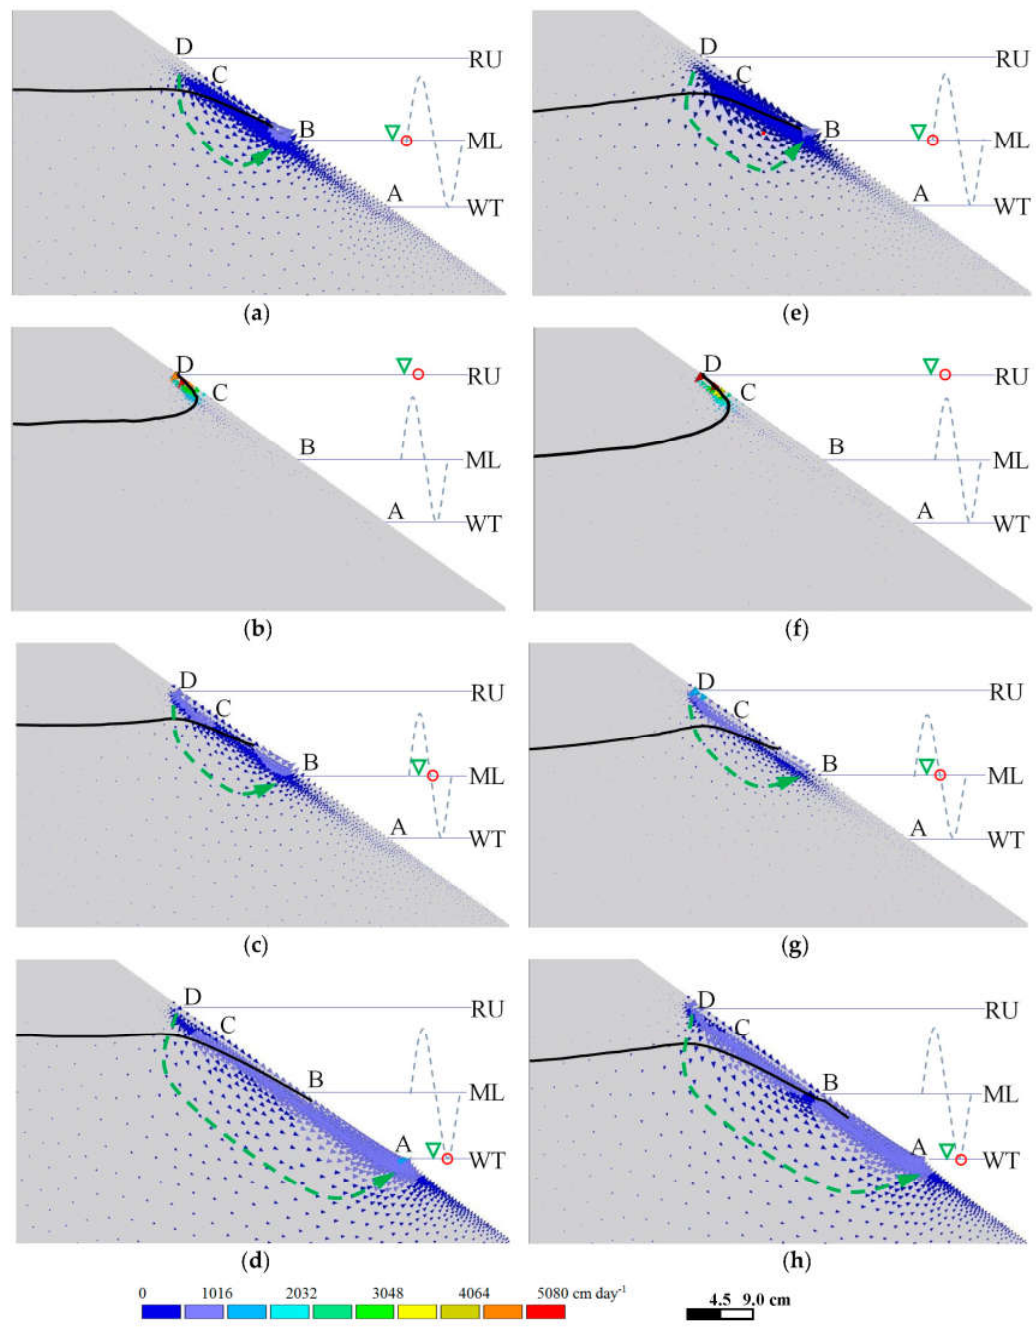
Figure 4. Local water flow patterns near the lake-groundwater interface at different stages of a wave cycle (indicated by a point on a sine wave) in the GDL ( a , b , c , d , left) and LRG ( e , f , g , h , right) cases. Black solid lines and green dashed arrow lines represent the groundwater table (zero pressure heads) and flow directions at a corresponding stage, respectively. ML, RU, and WT represent the mean lake level (38.5 cm), the run-up height (50 cm), and the wave trough (30 cm), respectively.